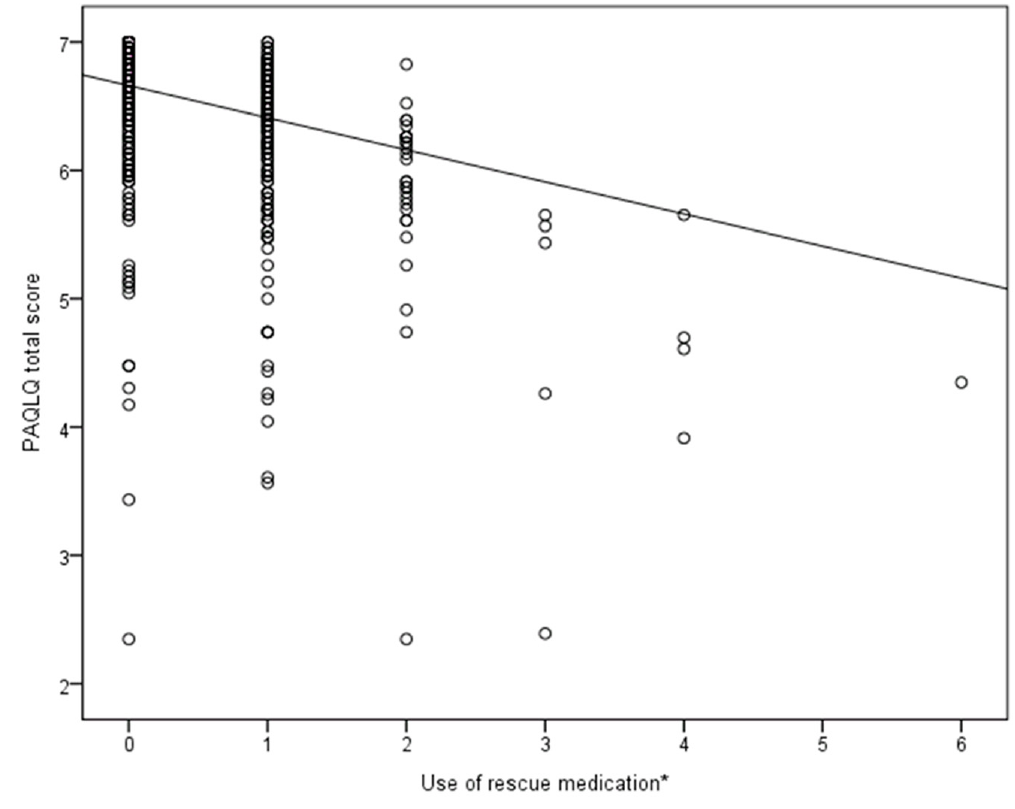
Figure 3. Associations between β 2 -agonist use and the PAQLQ total score in a linear mixed